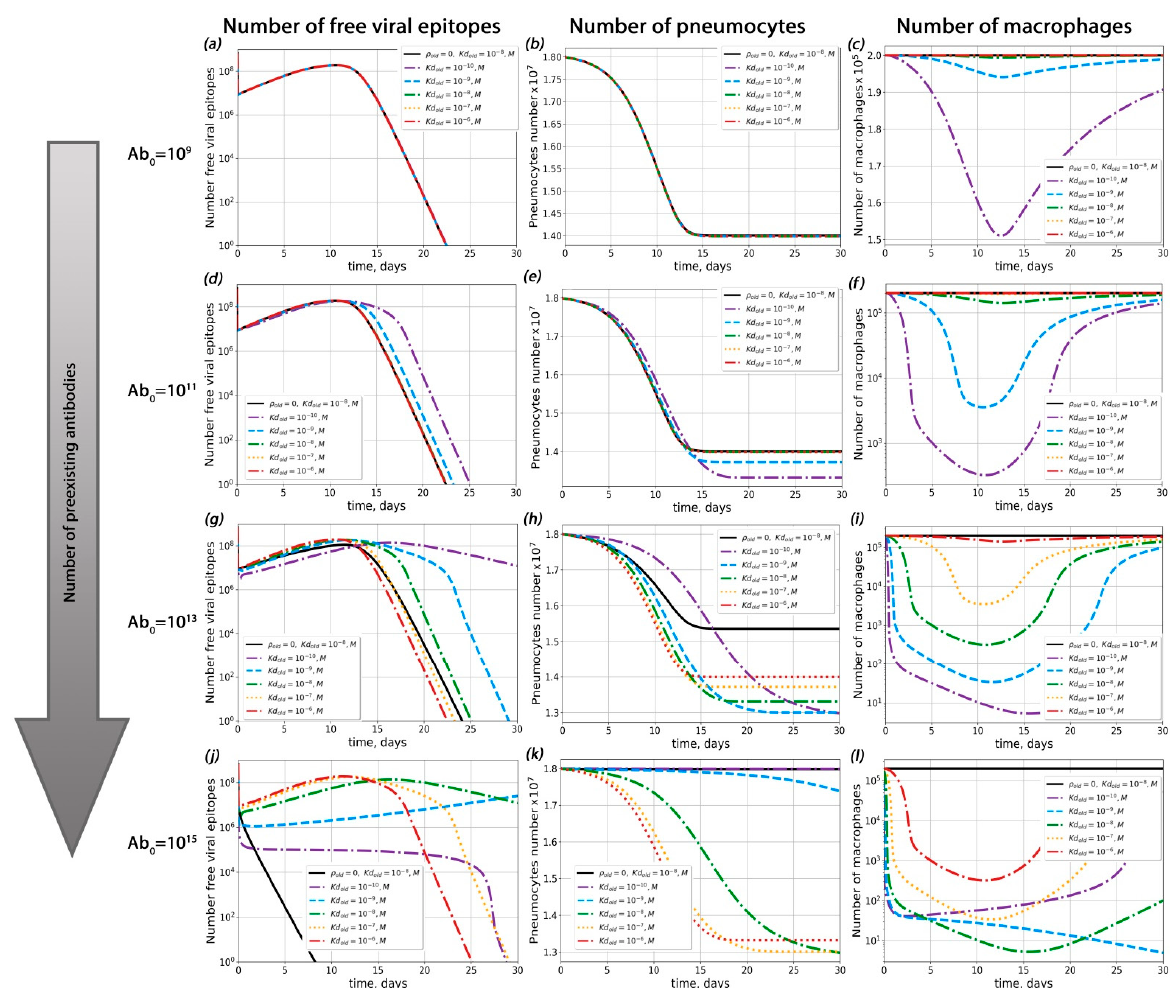
Figure 5. Influence of antigen–pre-existing antibody complex dissociation constant (Kd old ) on possible ADE occurrence. ( a – c ) Viral load dynamics ( a ), pneumocyte number ( b ) and macrophage kinetics ( c ) with different Kd old ( Ab old = 10 9 ). ( d – f ) Viral load dynamics ( d ), pneumocyte number ( e ) and macrophage kinetics ( f ) with different Kd old ( Ab old = 10 11 ). ( g – i ) Viral load dynamics ( g ), pneumocyte number ( h ) and macrophage kinetics ( i ) with different Kd old ( Ab old = 10 13 ). ( j – l ) Viral load dynamics ( j ), pneumocyte number ( k ) and macrophage kinetics ( l ) with different Kd old ( Ab old = 10 15 ).